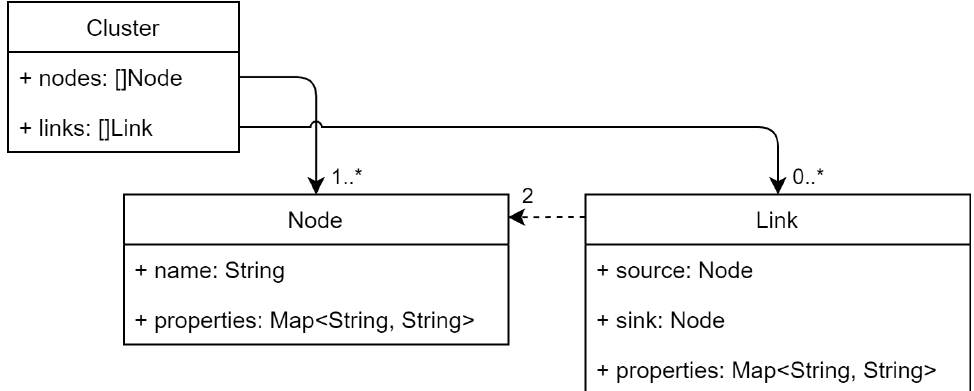
Figure 2. Infrastructure